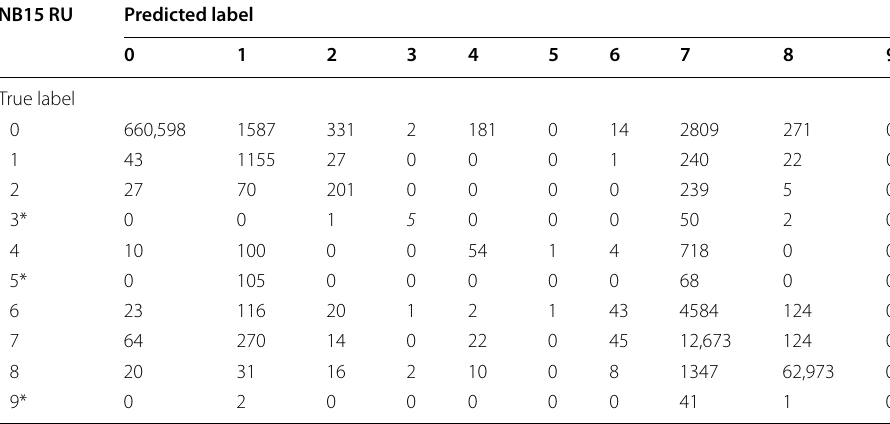
Table 23 Confusion Matrix: NB15 RU NB15